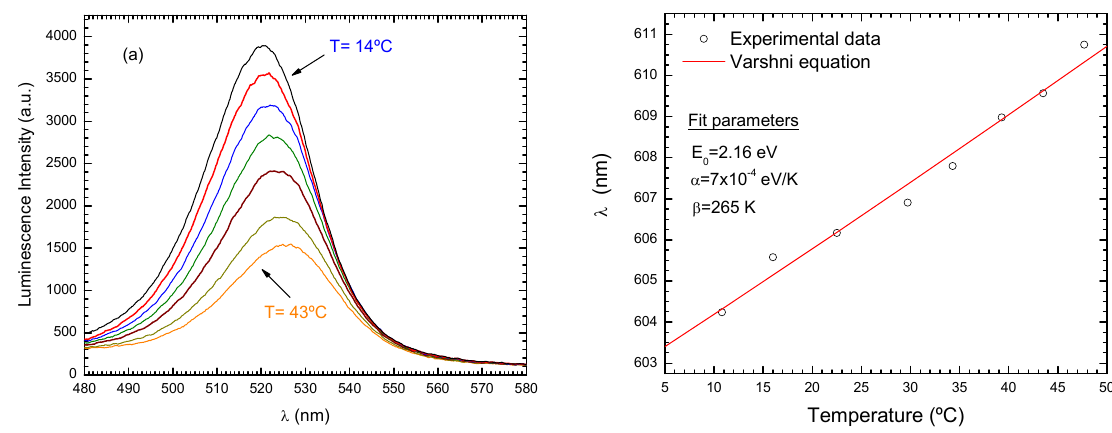
Figure 6. Temperature response of the luminescence emission of sol-gel immobilized CdSe/ZnS ; b) Peak emission wavelength nanocrystals for a range of 11ºC to 48ºC: a) Spectral response of QD 520 of QD as a function of 600